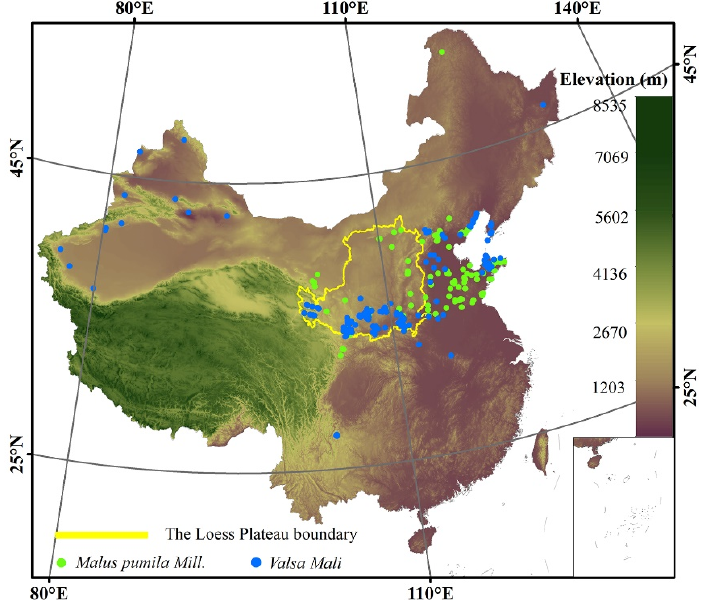
Figure 1. The occurrence data of Malus pumila Mill. and Valsa mali in China.